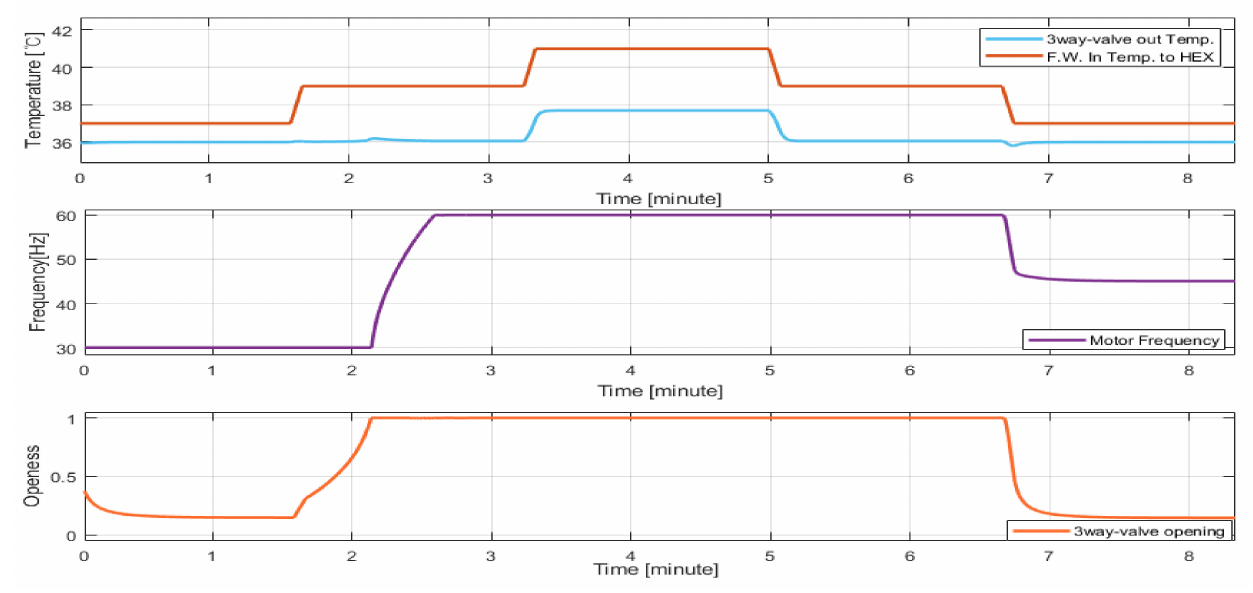
Figure 18. Test result graph of the typical PI control method.